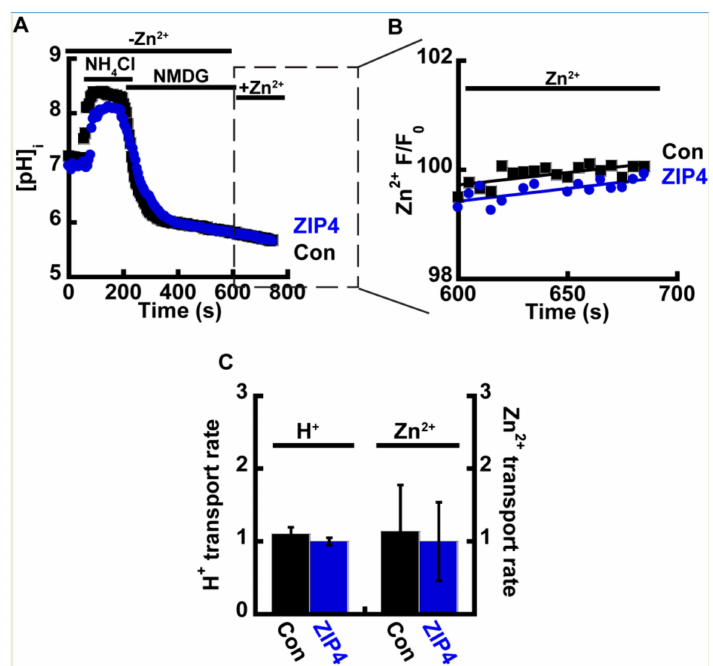
Figure 3. Intracellular acidification limits Zn 2 + uptake. ( A ) Representative traces of HEK293-T cells transfected with ZIP4 (blue) or an empty control vector (black), loaded with 1 µ M BCECF-AM, and subjected to ammonium pre-pulse paradigm to monitor cytoplasmic pH changes without extracellular acidification. ( B ) Corresponding Zn 2 + traces in cells loaded with 1 µ M Fluozin-3AM. Note that traces are presented only upon the addition of Zn 2 + , following acidification. ( C ) Normalized H + and Zn 2 + transport rates N ≥